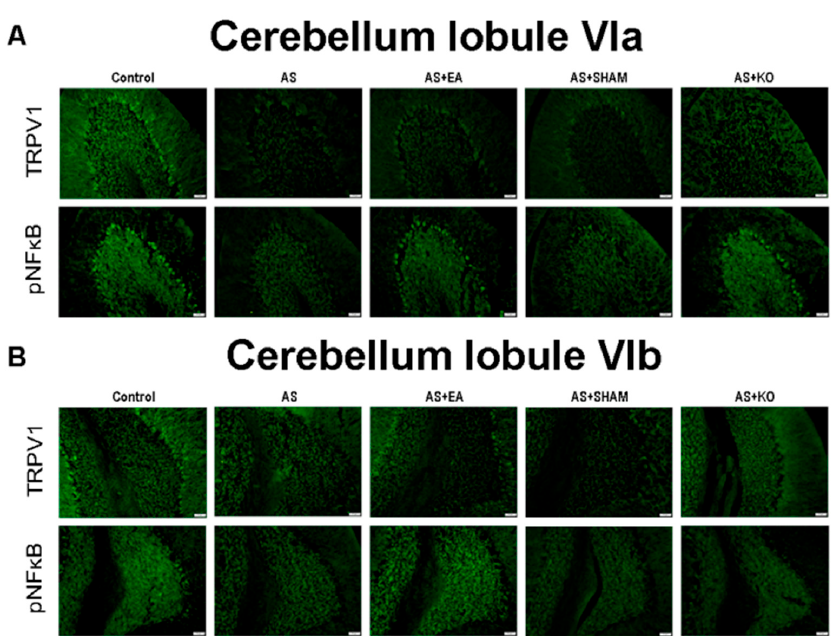
Figure 5. Immunofluorescence staining of TRPV1 and pNFkB protein expression in the cerebellum lobules VIa and VIb. There are 5 subject groups: Control, AS, AS + EA, AS + SHAM, and AS + KO.